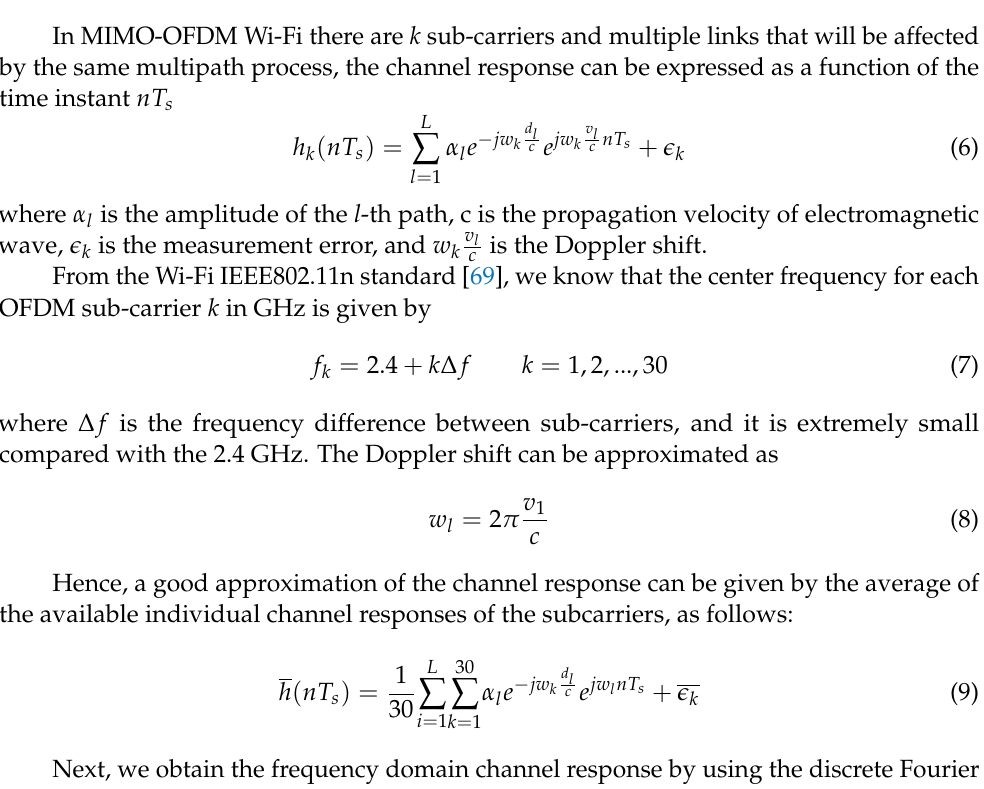
Figure 2. Doppler shifts produced by moving scatterers in a Wi-Fi